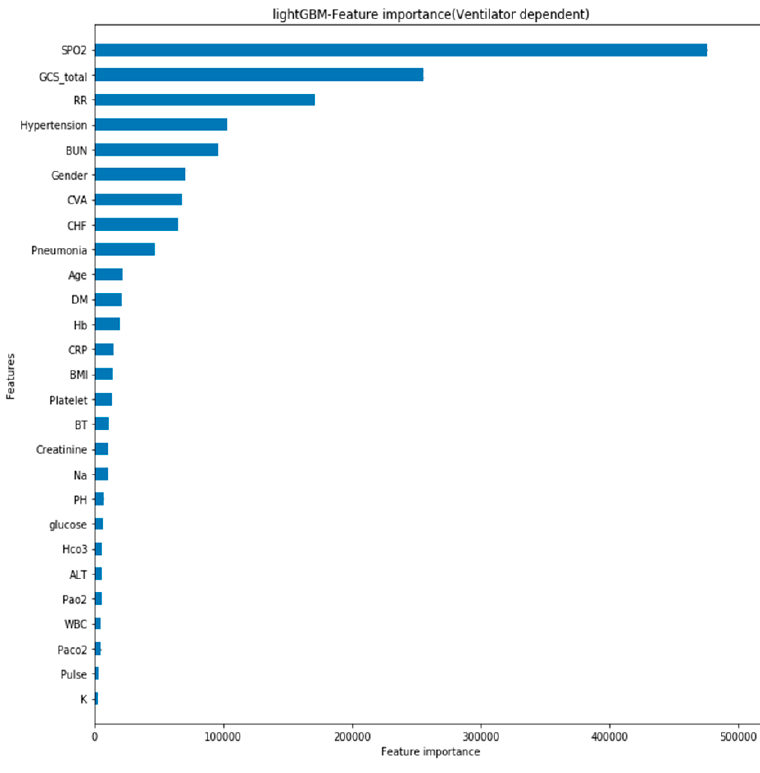
Figure 8. Feature importance of ventilator dependence.